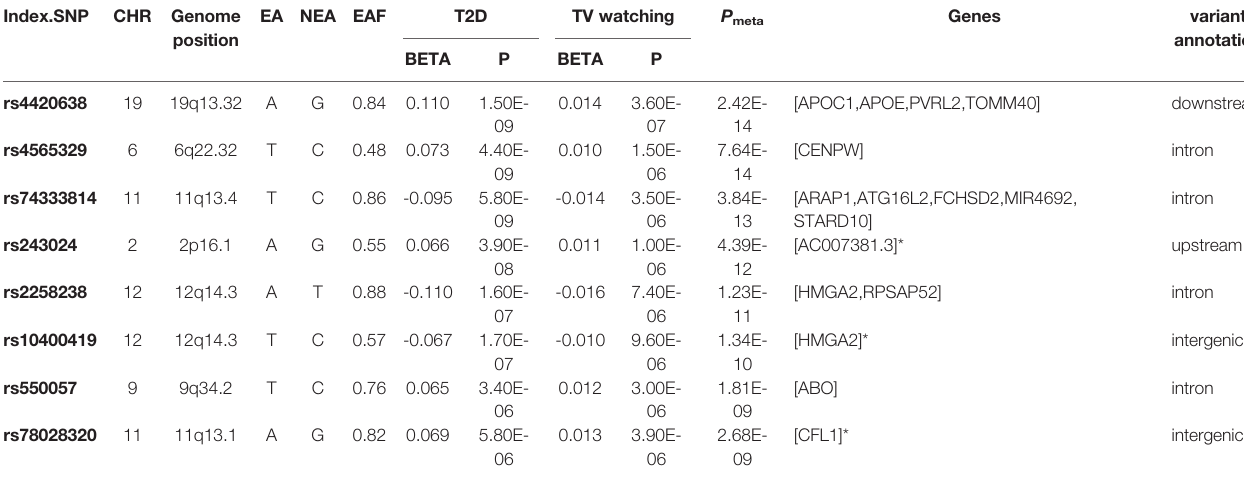
TABLE 5 | Cross-trait meta-analysis results between type 2 diabetes and television watching ( P meta < 2.5×10 -8 and single-trait P < 1×10 -5